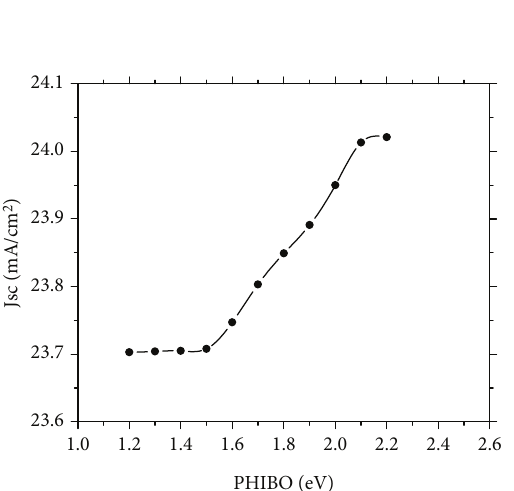
Figure 4: PHIBO versus Jsc plot of the proposed solar cell ’ s front contact.